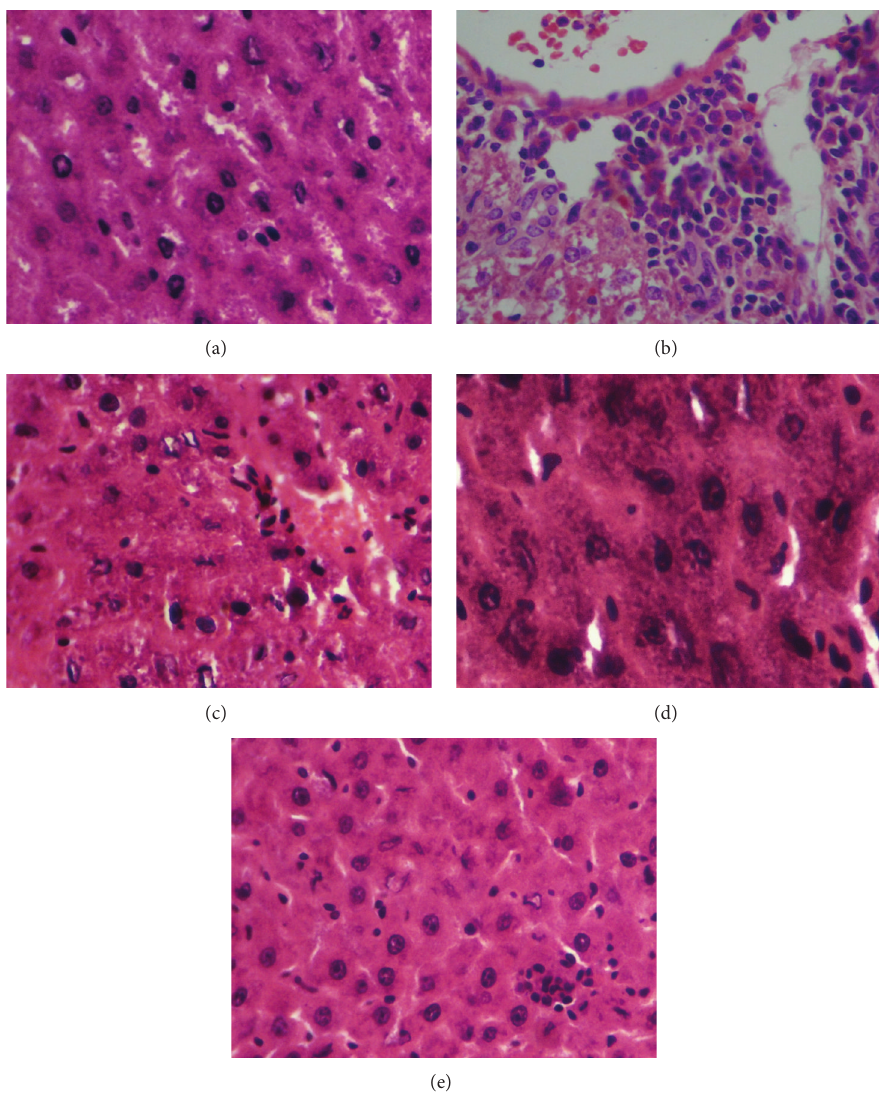
Figure 5: Histopathological changes in liver of experimental mice. Pictures shown are from representative liver sections collected at the end of the experimental period (a) normal; (b) acetaminophen-treated (nonextract treated) control; (c) acetaminophen + silymarin (d) acetaminophen + Liv52; (e) acetaminophen + A. nilotica